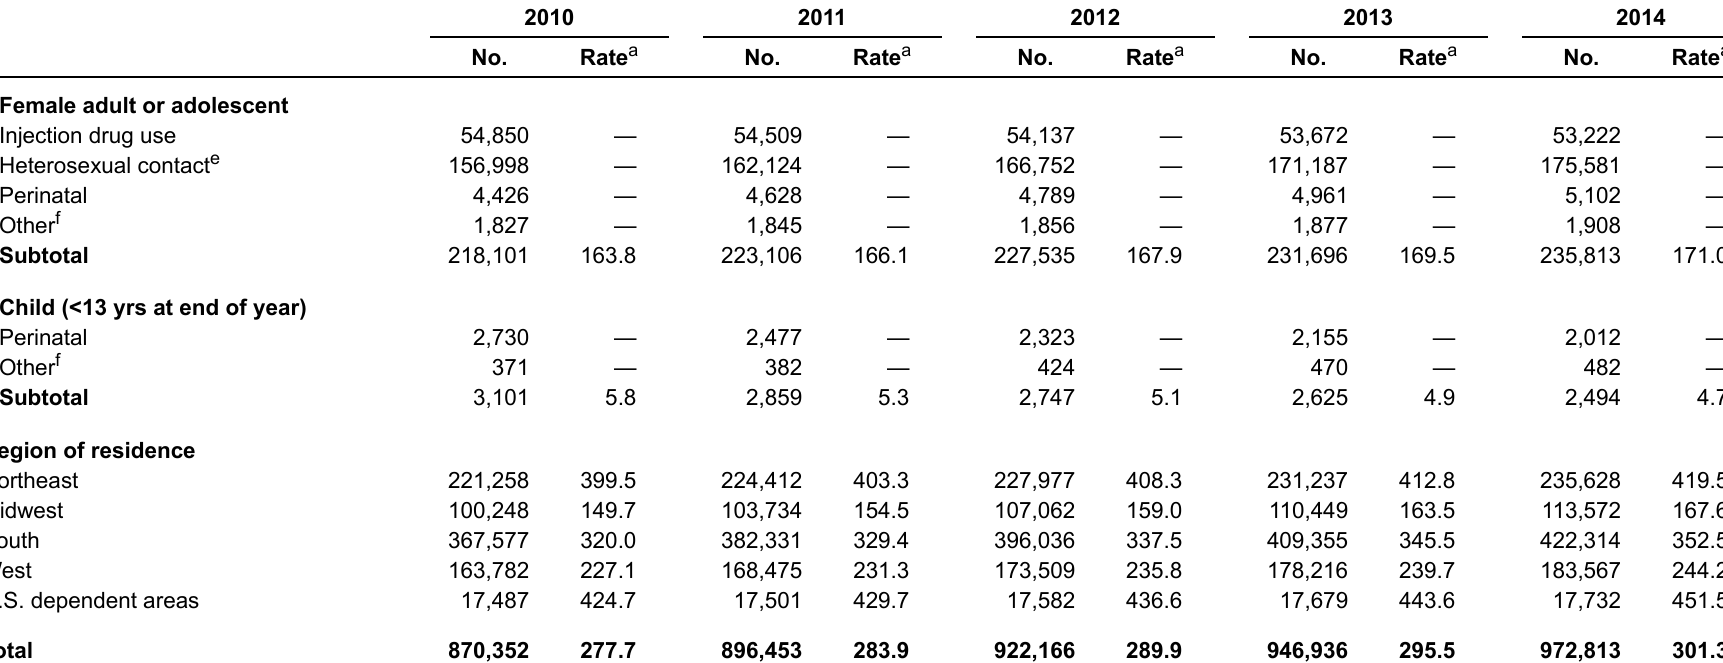
Table 18b. Persons living with diagnosed HIV infection, by year and selected characteristics, 2010–2014—United States and 6 dependent areas